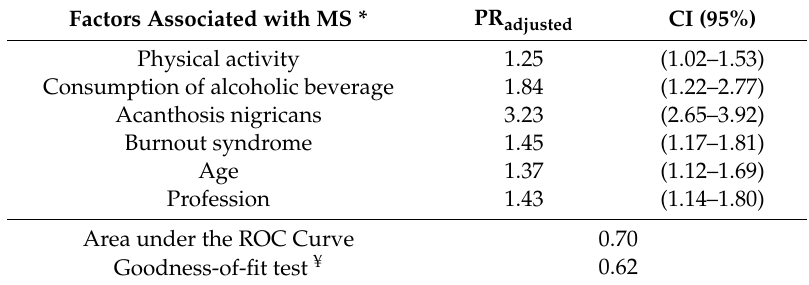
Table 3. Factors associated with metabolic syndrome in primary health care nursing professionals, obtained by multivariate